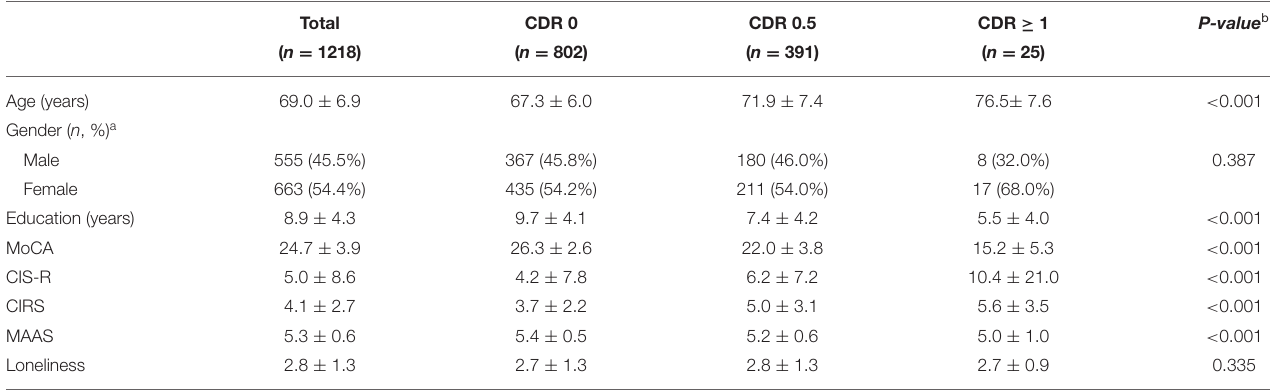
TABLE 1 | Demographic characteristics of sample.